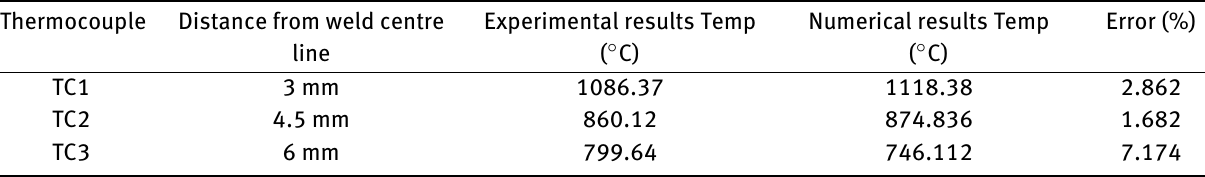
Table 2: The Peak temperatures comparison between experimental and numerical results Thermocouple